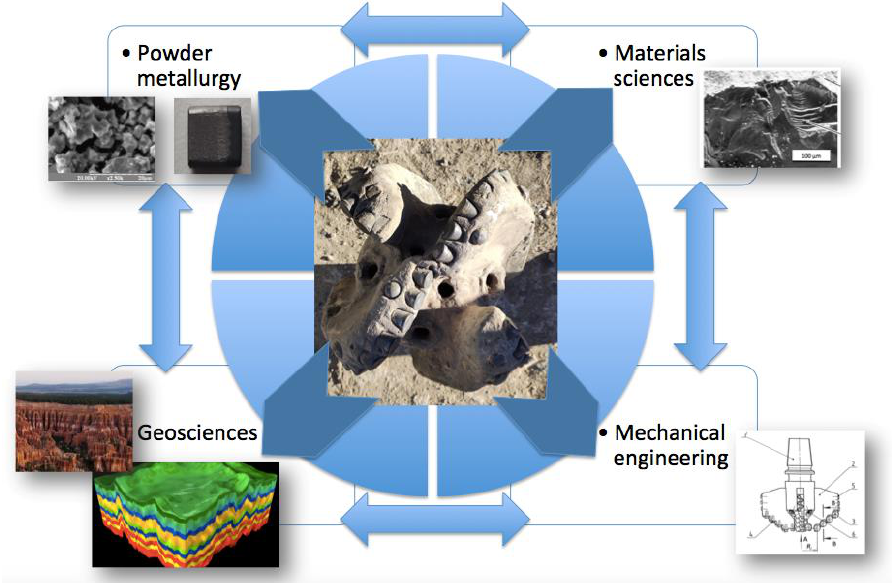
Figure 2. Interdisciplinary dependence between research approaches on well drilling efficiency.